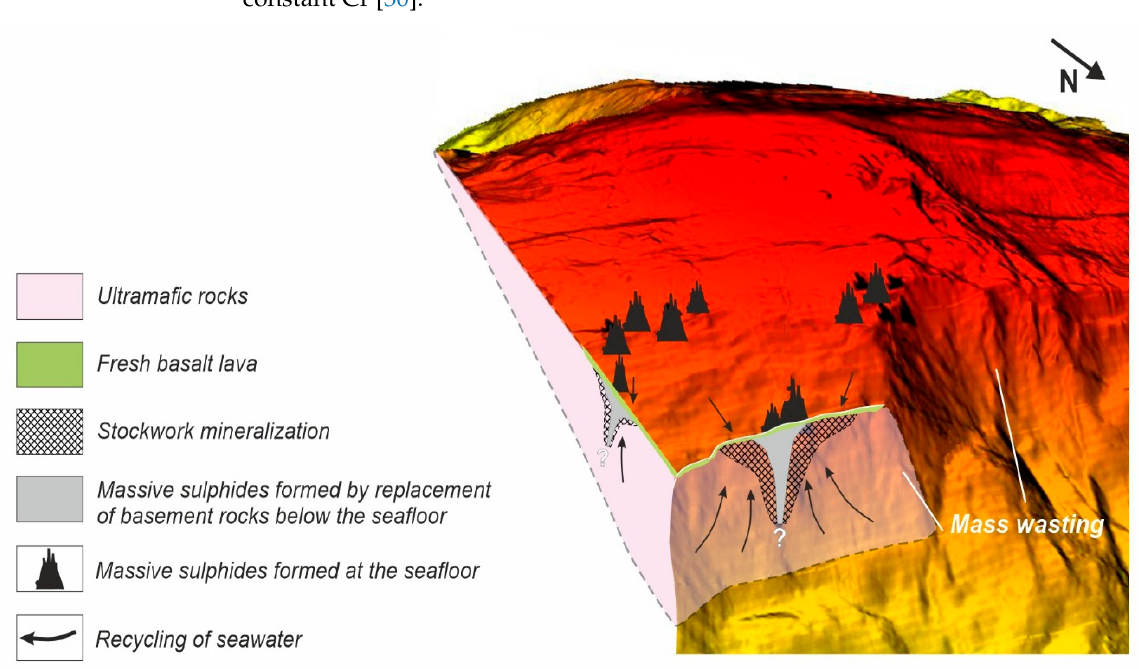
Figure 18. The model of inner structure of the Semenov-5 hydrothermal field. The bathymetry data is from Escartin et al. [20].